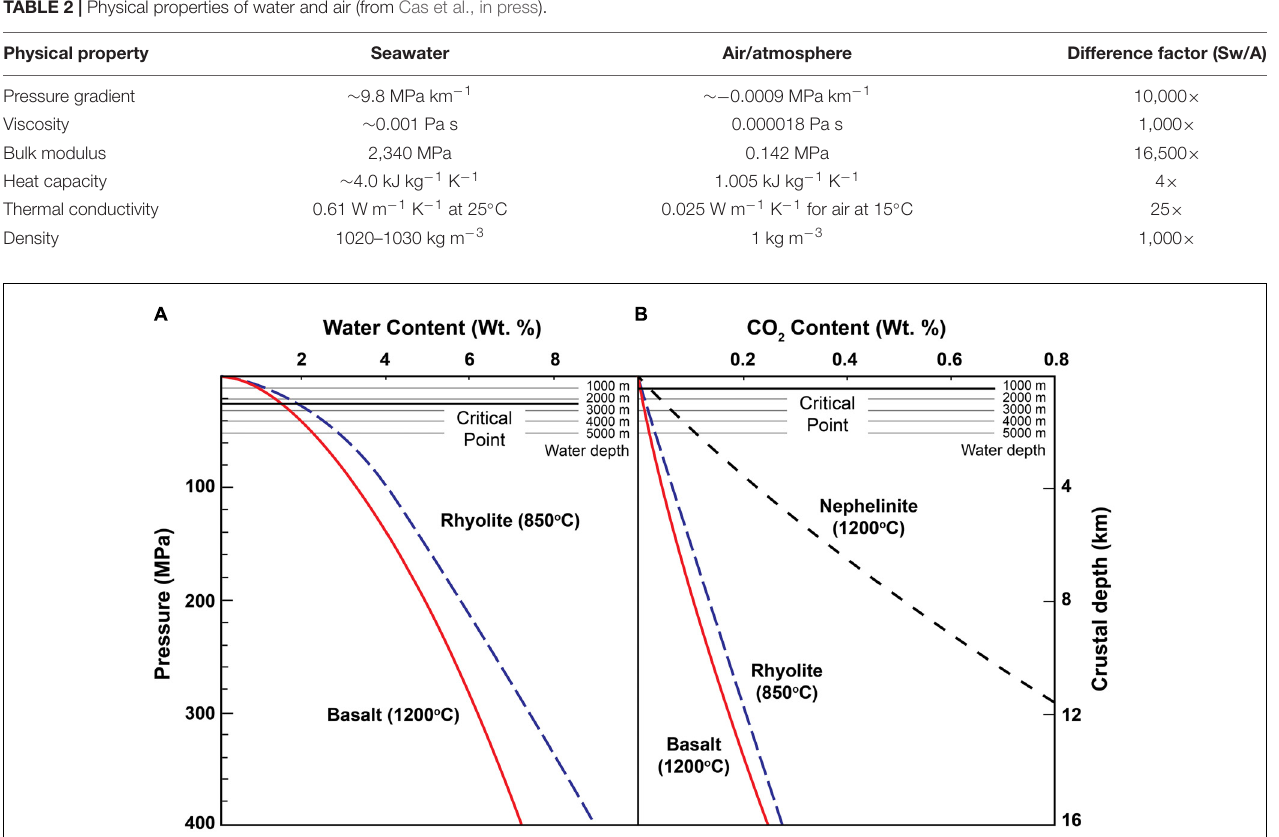
FIGURE 2 | Volatile saturation curves for (A) H 2 O and (B) CO 2 in basalt and rhyolite magmas as a function of confining pressure and equivalent depth in the crust. Also shown are hydrostatic pressure lines corresponding with particular water depths. Exsolution of volatiles would be short-circuited if eruption occurred at those water depths, indicating that less of the volatile fraction would exsolve in subaqueously erupting magmas compared with equivalent magmas erupting and decompressing to atmospheric pressures of 0.1 MPa. (Volatile and pressure data from Wallace et al., 2015, Figures 7.1, 7.2, respectively, other parameters are ours).